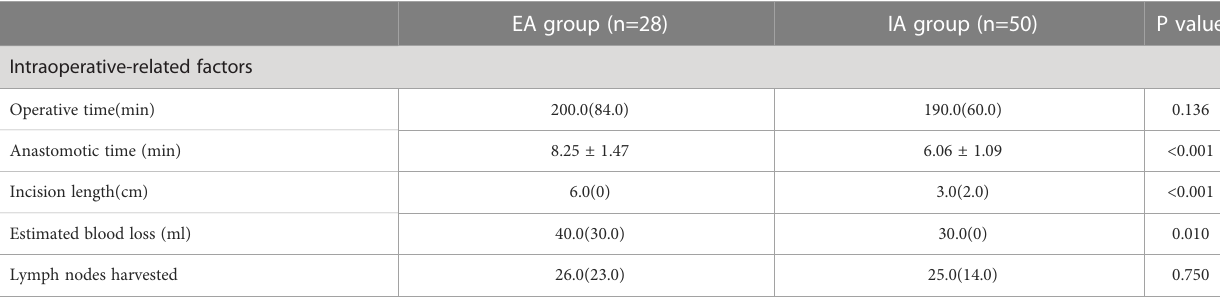
TABLE 2 Intraoperative conditions of including